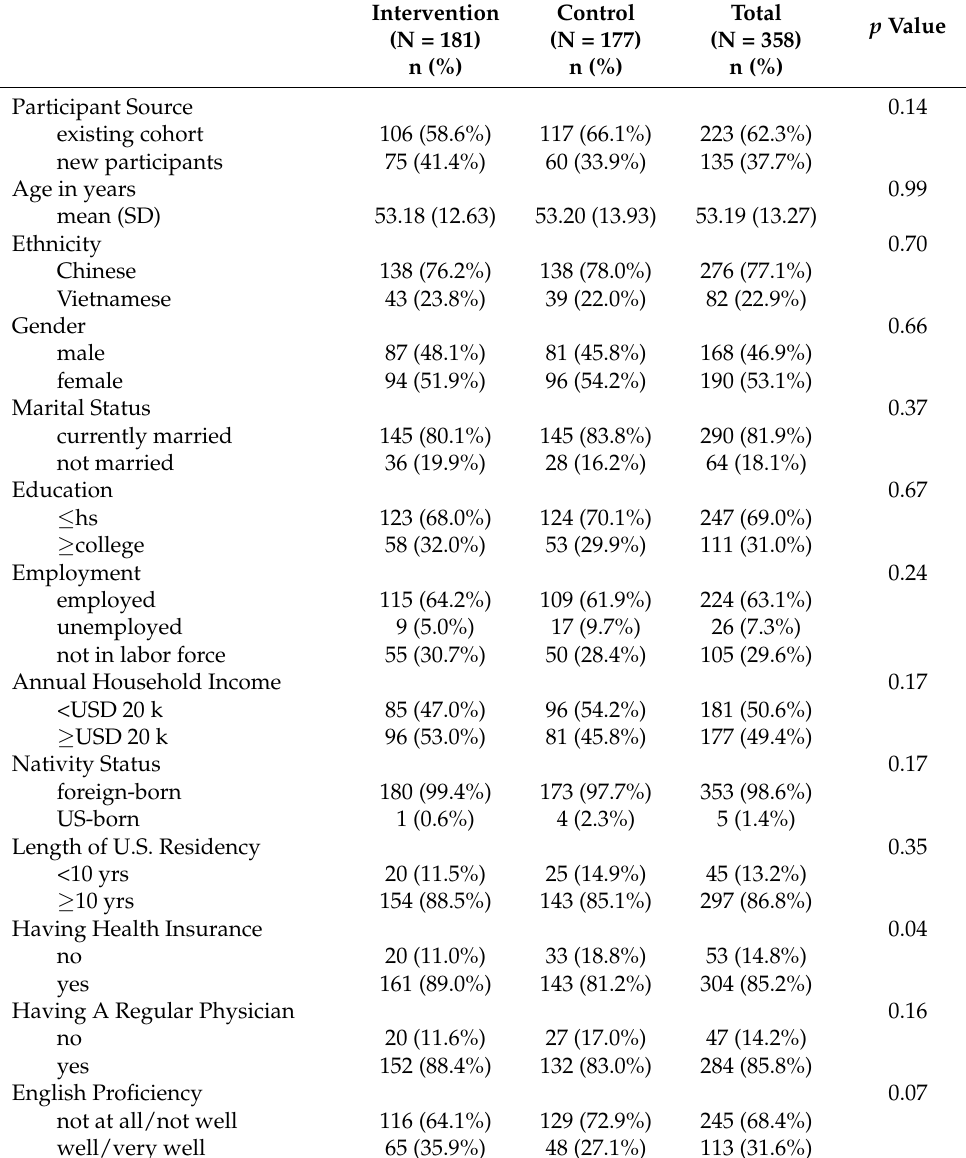
Table 1. Sociodemographic and health-related characteristics of the sample, in total and by study